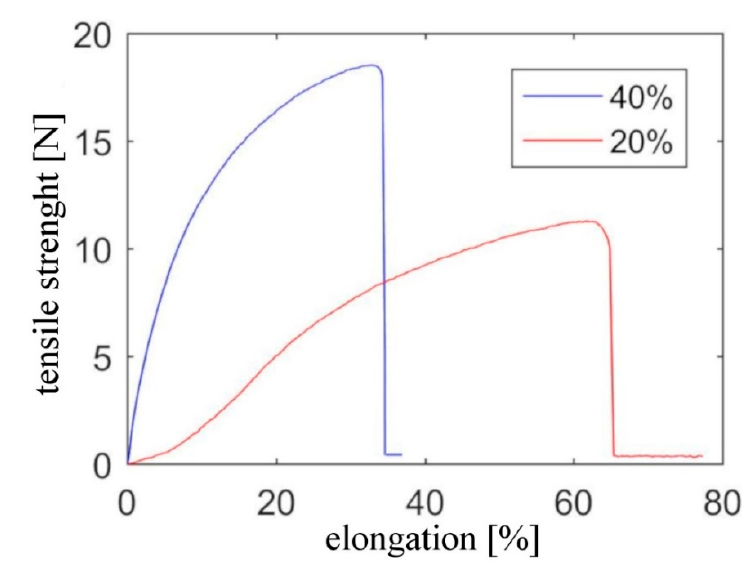
Figure 5. Stress and strain curves of composite fibers containing 20% and 40% w / w of